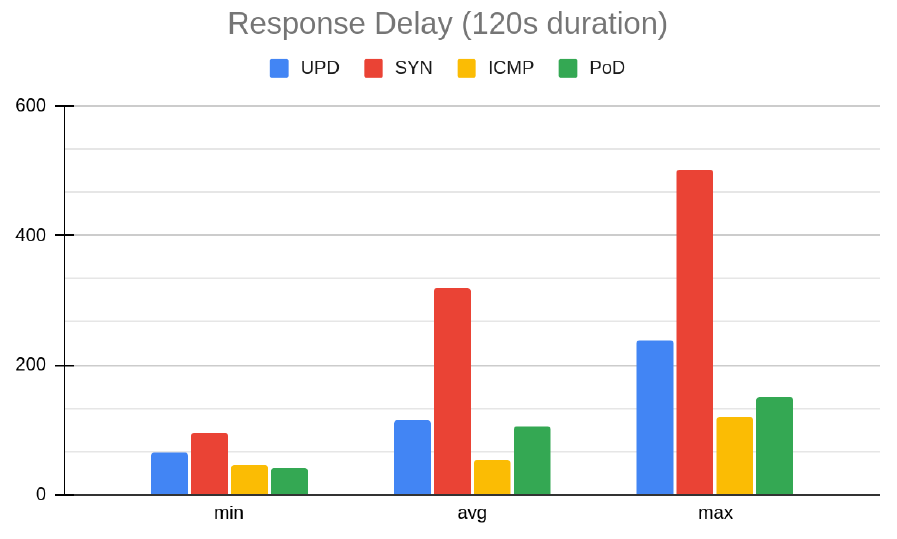
Figure 2. Response delay during